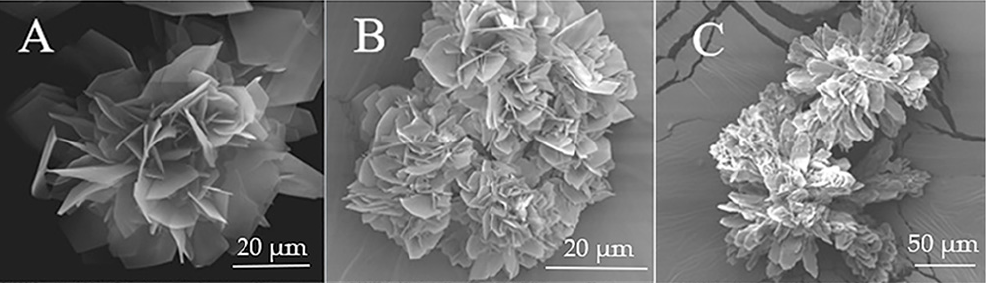
Figure 1. Scanning electron microscopy, pictures of L-glu crystallized without ions ( A ) and with sodium ions ( B ) and potassium ions ( C ) in water–ethanol mixtures.